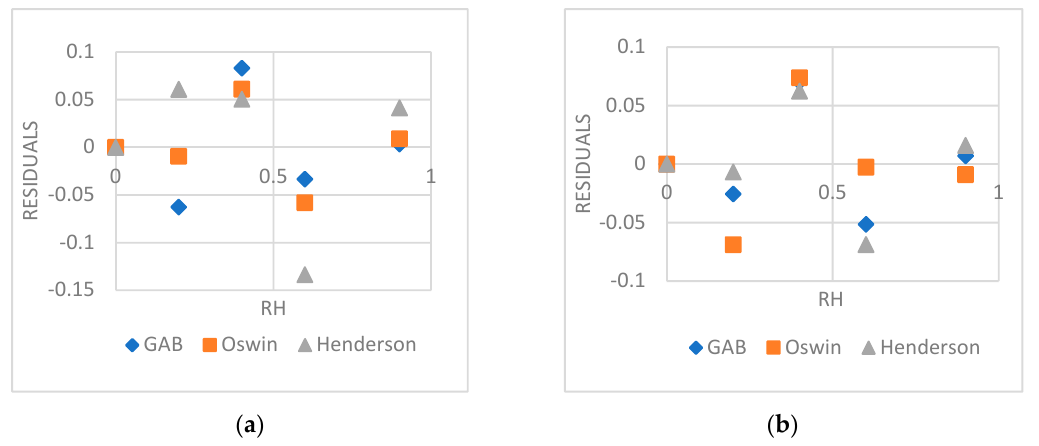
Figure 3. Residuals of the different models: ( a ) spruce–switchgrass and ( b ) pine–switchgrass.